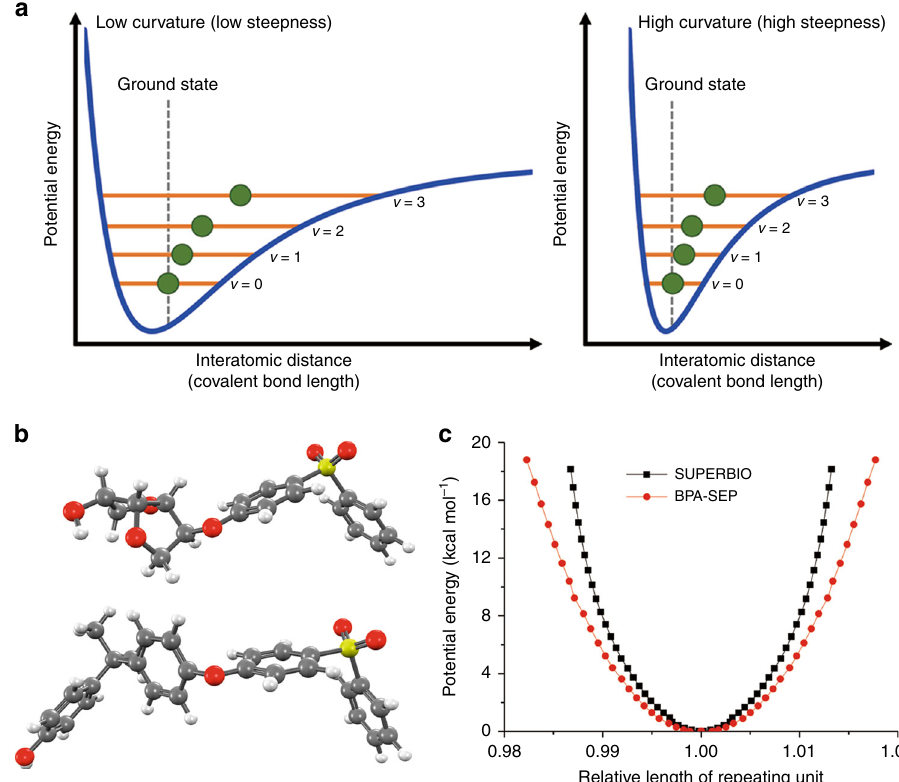
Fig. 3 Quantum chemical simulation. a Schematic illustration of different vibration energy levels in a potential energy well ( x -axis: interatomic distance). b Optimised ground state geometries of (top) SUPERBIO and (bottom) BPA-SEP repeating units. C, black; H, white; O, red; and S, yellow. c Potential energy curve along with relative length of repeating